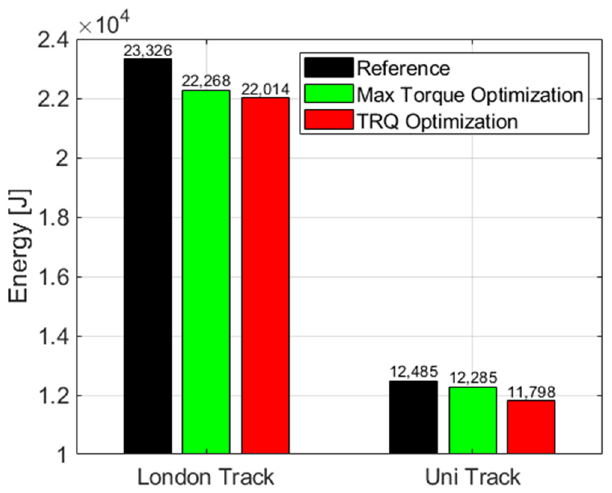
Figure 15. The energy demand of the studied track optimization methods.